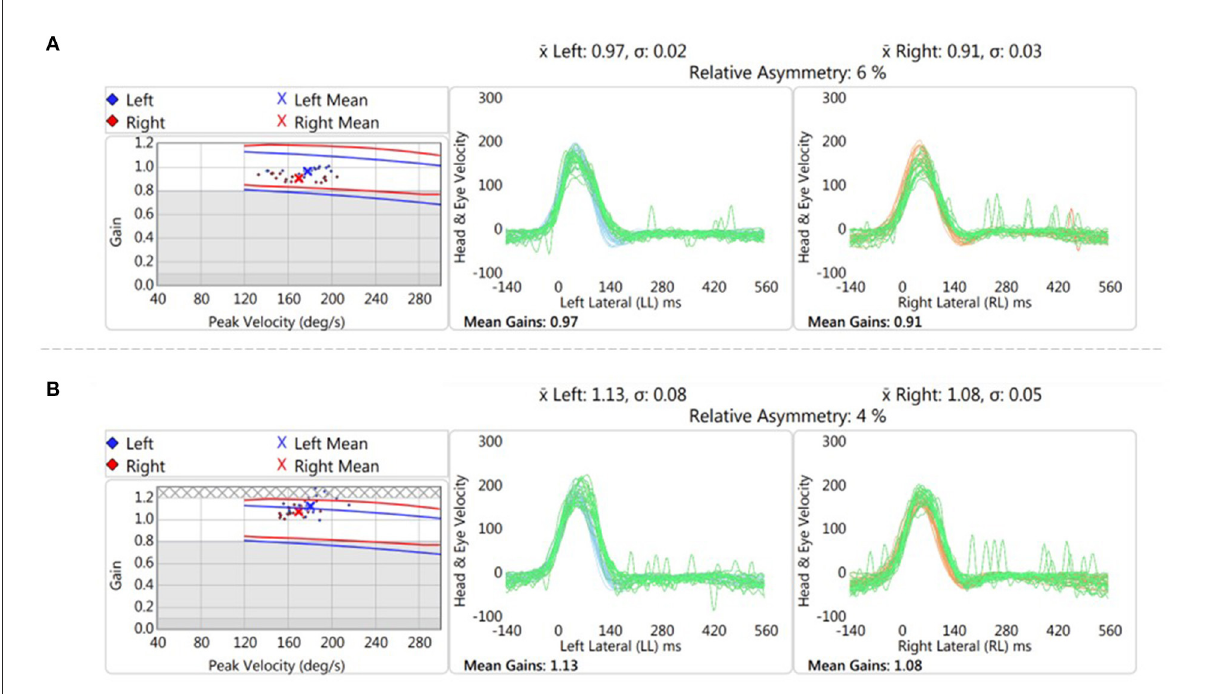
FIGURE3 Representative trace of vHIT testing pre (A) and post (B) headshake in an VM patient in the acute phase. There was an increase of 0.165 in the gain after the head oscillation